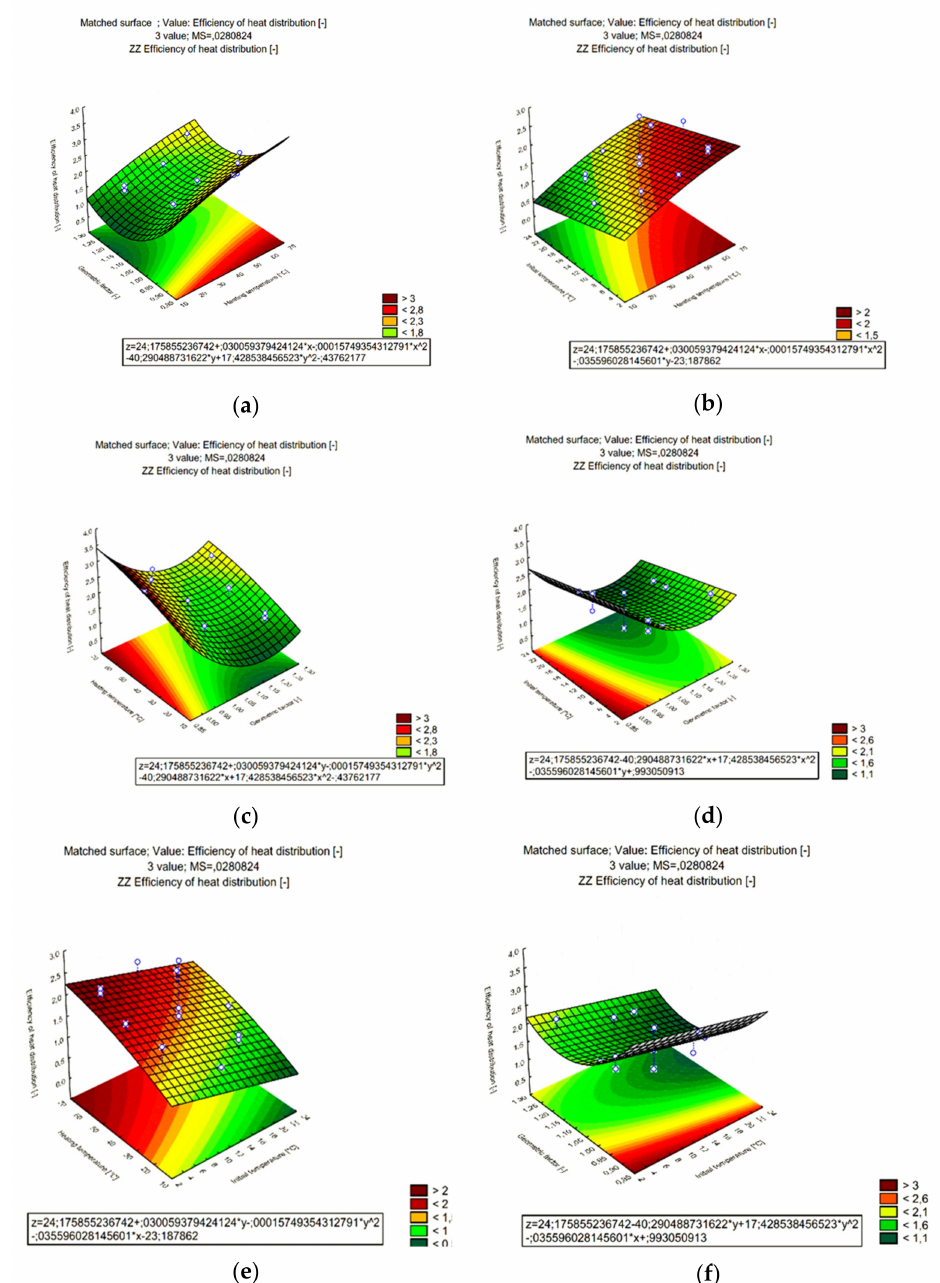
Figure 21. Formation of graphs of approximating functions in the form of planes of input variable responses to the value of the heat distribution coefficient of the PCM composite with carbon recyclate, ( a ) The plane of the heating temperature response to the geometrical coefficient, ( b ) The plane of the heating temperature response to the initiation temperature, ( c ) The plane of geometrical coefficient response to the heating temperature, ( d ) The plane of geometrical coefficient response to the initiation temperature, ( e ) The plane of the initiation temperature response to the heating temperature, ( f ) The plane of the initiation temperature response to geometrical